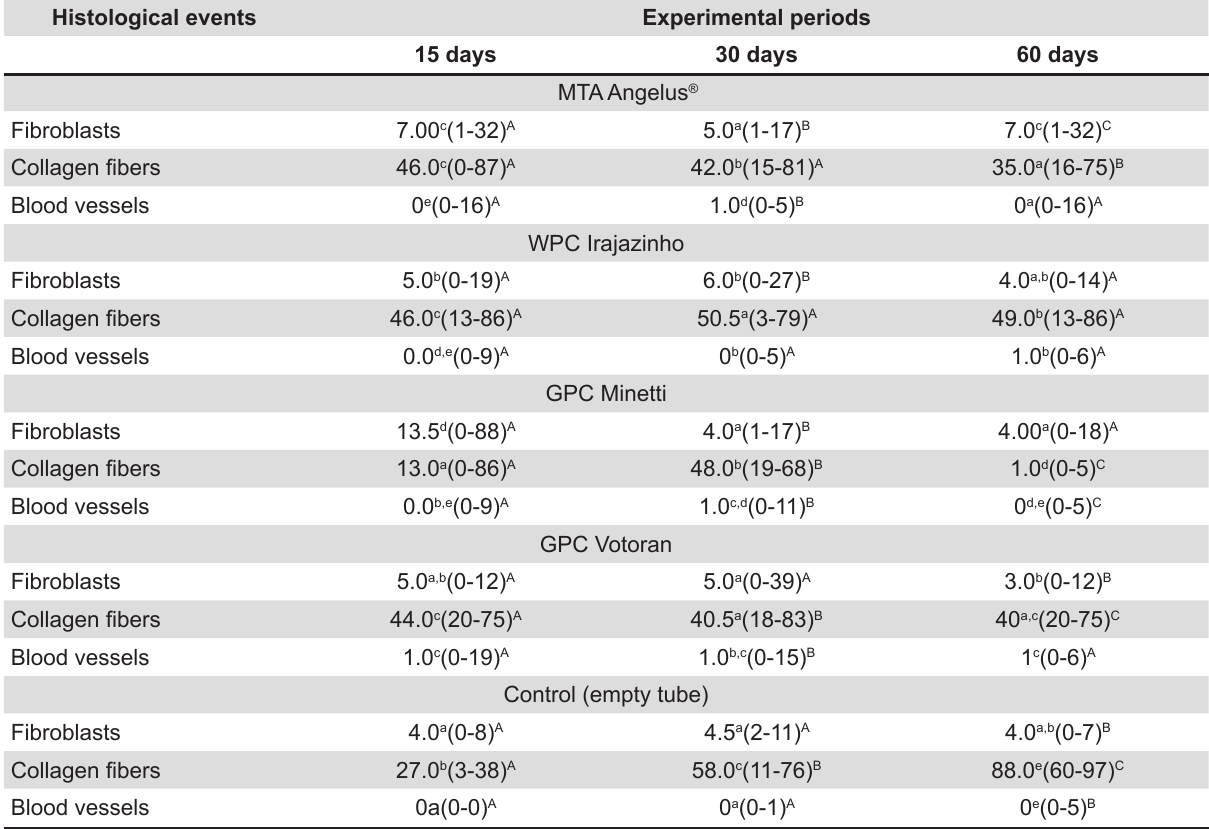
Same letters represent absence of statistical significance. Uppercase letters represent period. Lowercase letters represent